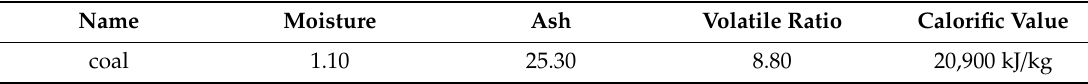
Table 14. Raw coal industry analysis